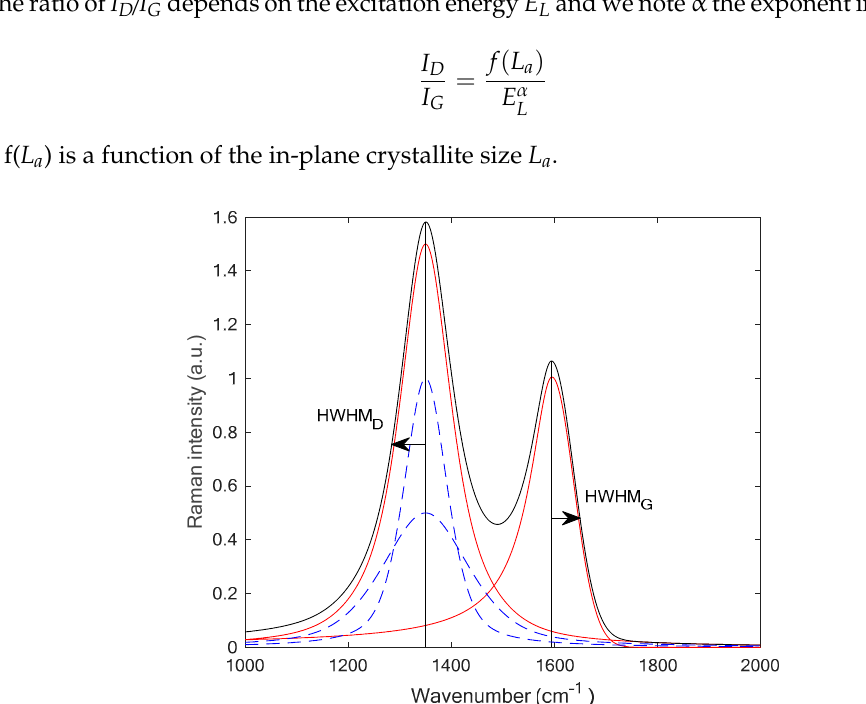
Figure 1. Typical Raman spectrum (black line) for a disordered carbon showing the principle of hand-made measurement of the half width at half maximum ( HWHM ). HWHM D ( HWHM D ) is for the D band (G band respectively). The G and D band contributions are plotted in red. The dotted blue reports the D band decomposition in two Voigt sub-bands (same wavenumber).